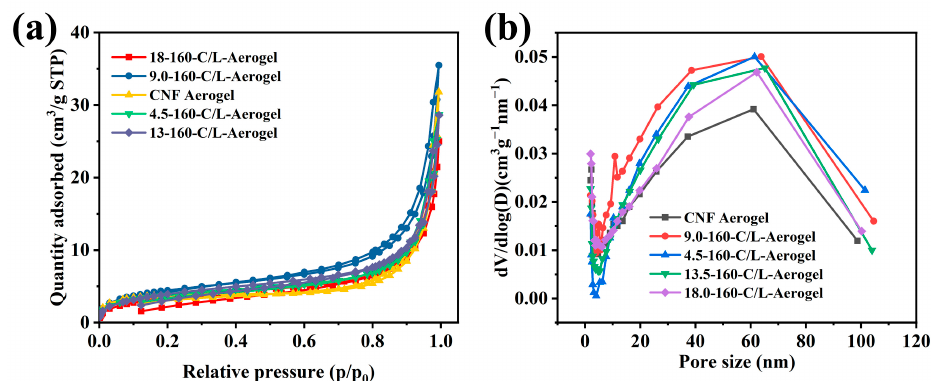
Figure 7. Analysis of N 2 sorption isotherms and pore size distribution. ( a ) N 2 sorption isotherms at 77 K of the CNF/nano-lignin aerogels; ( b ) pore size distributions of the CNF/nano-lignin aerogels.